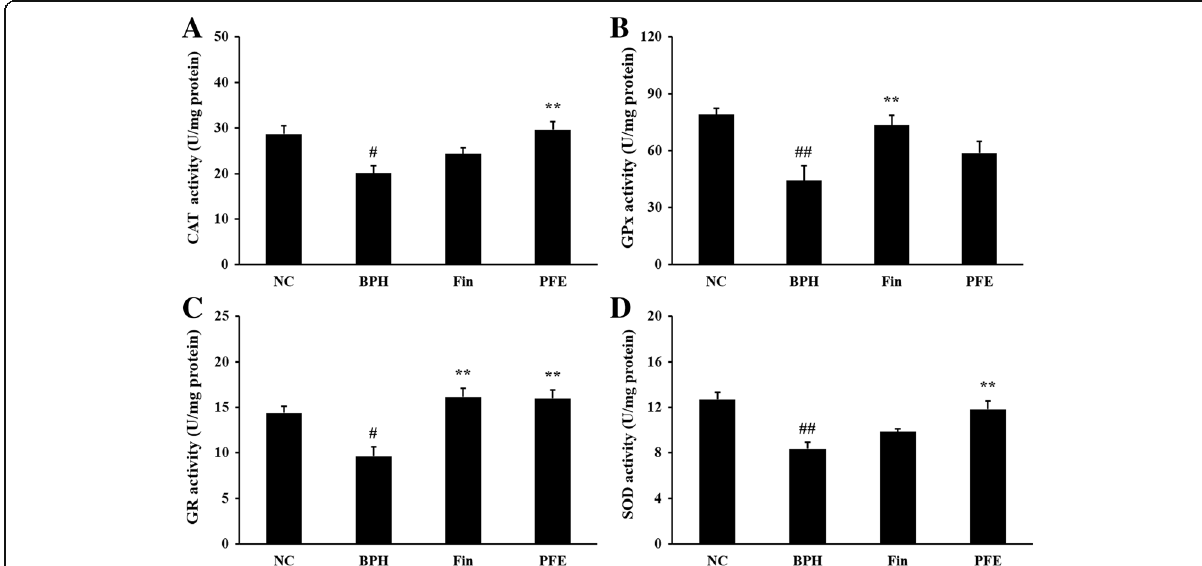
Fig. 6 Effect of PFE on the activities of antioxidant enzymes in prostatic tissue. Individual data were obtained using assay kits: ( a ) CAT, ( b ) GPx, ( c ) GR, and ( d ) SOD. NC (normal control group), corn oil injection (s.c.) + PBS administration (p.o.); BPH (control group), TP (3 mg/kg)/corn oil injection (s.c.) + PBS administration (p.o.); Fin (positive control group), TP (3 mg/kg)/corn oil injection (s.c.) + finasteride administration (10 mg/kg, p.o.); PFE (PFE-treated group), TP (3 mg/kg)/corn oil injection (s.c.) + PFE administration (200 mg/kg, p.o.). Data are presented as mean ± S.E.M. ( n = 6). Significant differences at # P < 0.05 and ## P < 0.01 compared with the NC group. Significant differences at ** P < 0.01 compared with the BPH group. BPH, benign prostatic hyperplasia; CAT, catalase; Fin, finasteride; GPx, glutathione peroxidase; GR, glutathione reductase; PBS, phosphate- buffered saline; PFE, Ponciri fructus extract; p.o., peroral; s.c., subcutaneously; SOD, superoxide dismutase; TP, testosterone